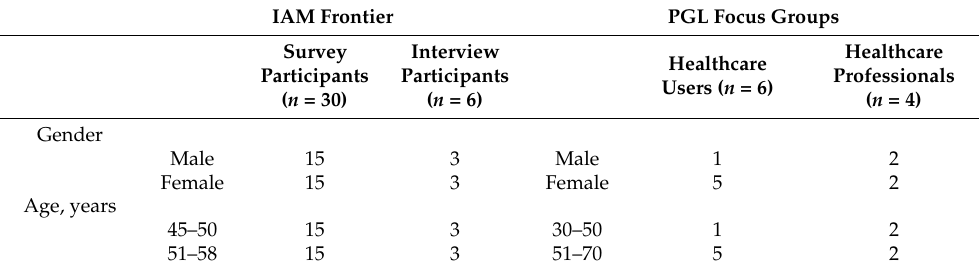
Table 1. Demographic characteristics IAM Frontier and PGL